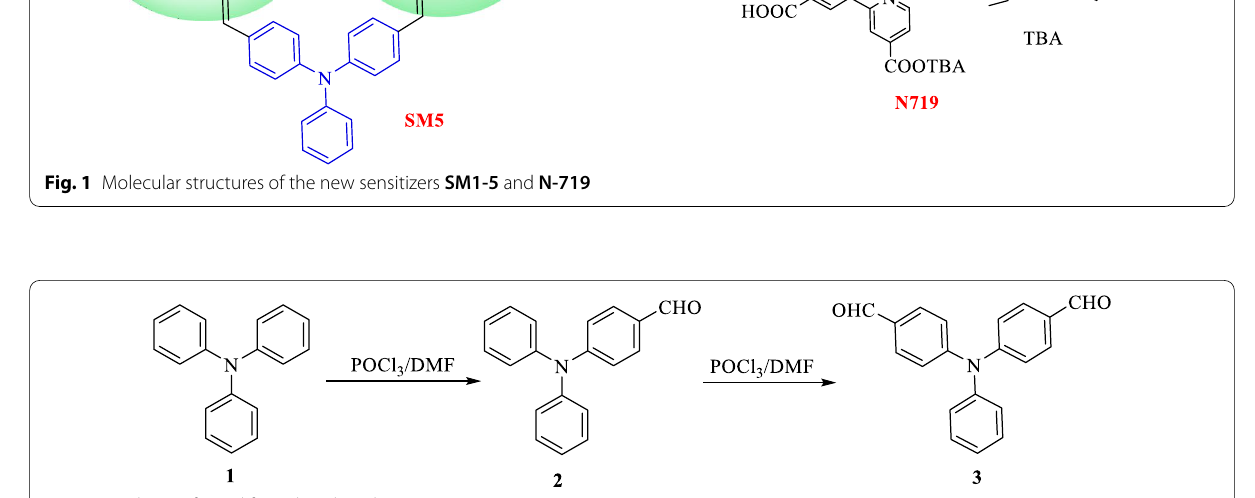
Fig. 2 Synthesis of 4,4’‑diformyl‑triphenylamine ( 3